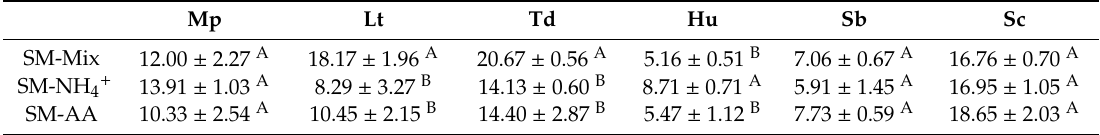
Table 1. Maximum growth (expressed as OD 600 ) during single fermentations under three nitrogen conditions (SM-Mix, SM-NH 4 + , and SM-AA), for each yeast species: M. pulcherrima (Mp), L. thermotolerans (Lt), T. delbrueckii (Td), H . uvarum (Hu), S. bacillaris (Sb), and S. cerevisiae (Sc). Capital letters indicate significant differences in each species between the three media. SM-Mix: a 191 mixture of organic and inorganic nitrogen; SM-NH 4+ : inorganic nitrogen only; AM-AA: organic 192 nitrogen only. 193